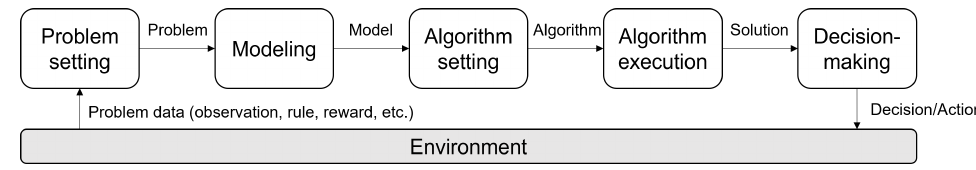
Figure 5. The AHMSS design